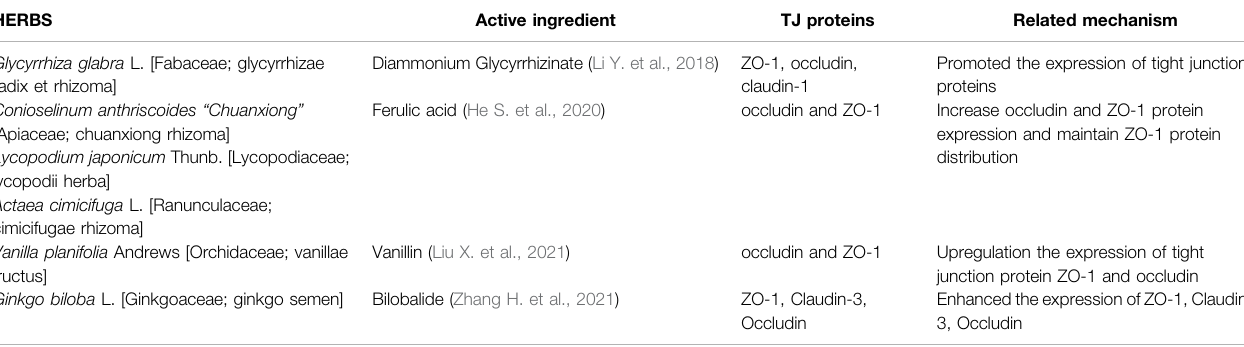
TABLE 2 | ( Continued ) Herbs for the treatment of COVID-19 that can affect the expression of tight junction